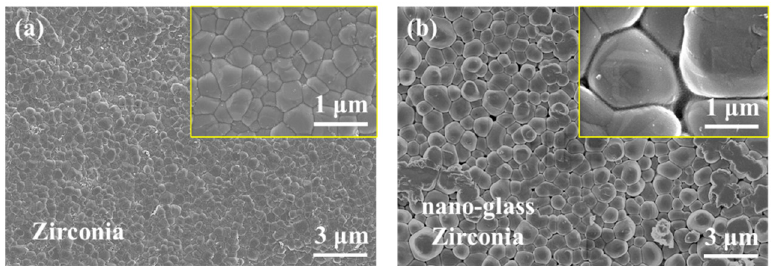
Figure 2. Typical SEM images of zirconia surface morphology: zirconia sintered following the recommended procedure ( a ) and sintered zirconia after modification ( b ).